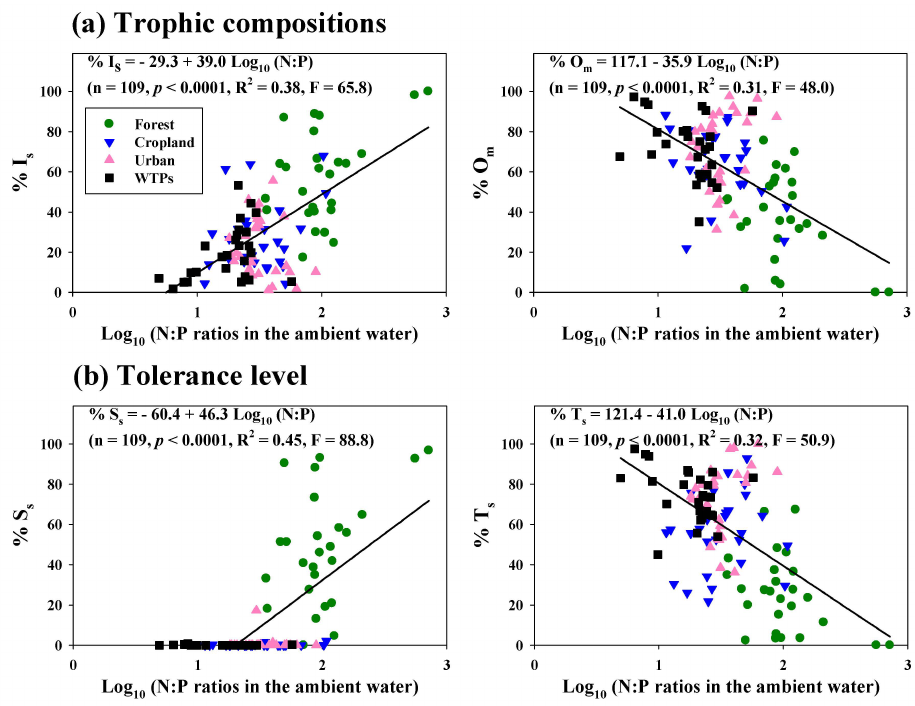
Figure 8. Scatter and simple linear regression models of ( a ) log 10 -transformed N:P ratios-trophic composition (% I s , left ; % O m , right ); and ( b ) log 10 -transformed N:P ratios–tolerance level (% S s , left ; % T s , right ) in the Geum River watershed. Forest = ‚ (closed circle); cropland = down); urban = (cid:78) (closed triangle up); wastewater treatment plants = (cid:4) (closed